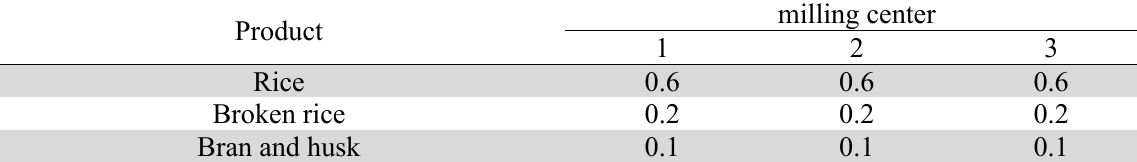
Conversion ratio of paddy to final